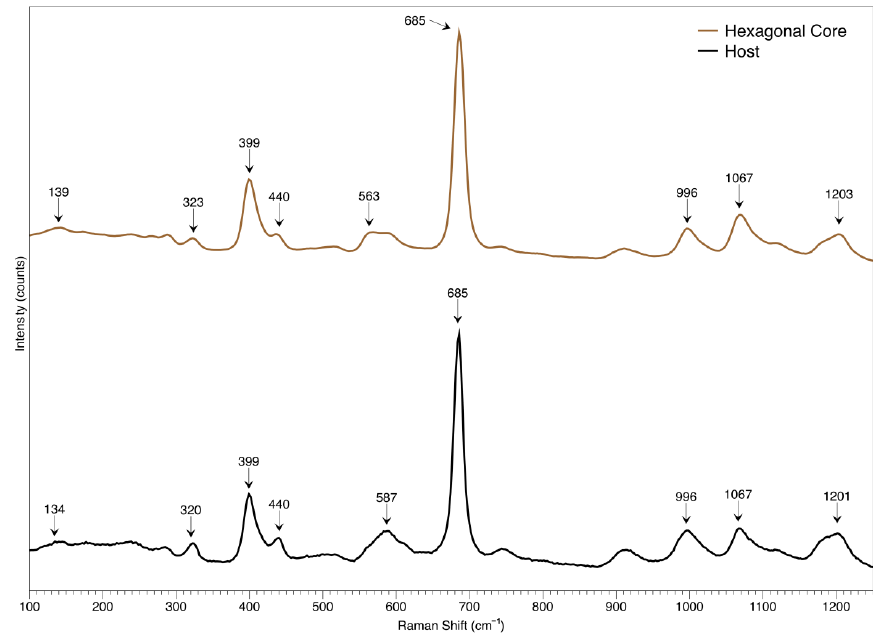
Figure 27. Raman spectrum identified the core as beryl, consistent with the emerald host.